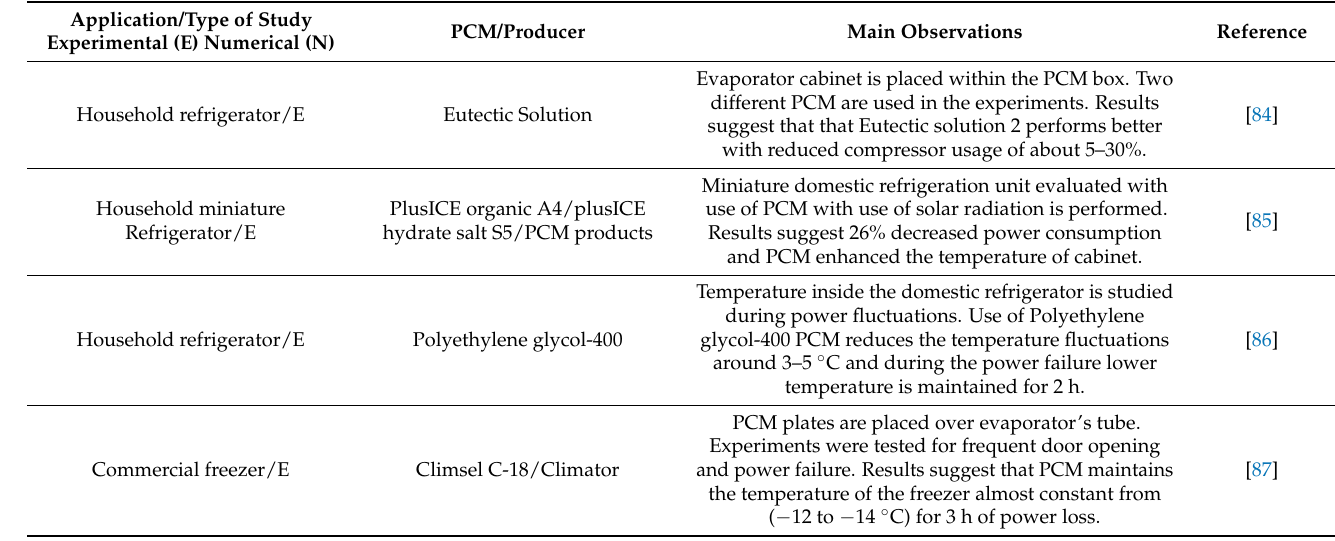
Figure 5. Experimental freezer used in laboratory [84]. Table 6. Summary of studies using PCM in domestic refrigeration and freezers.